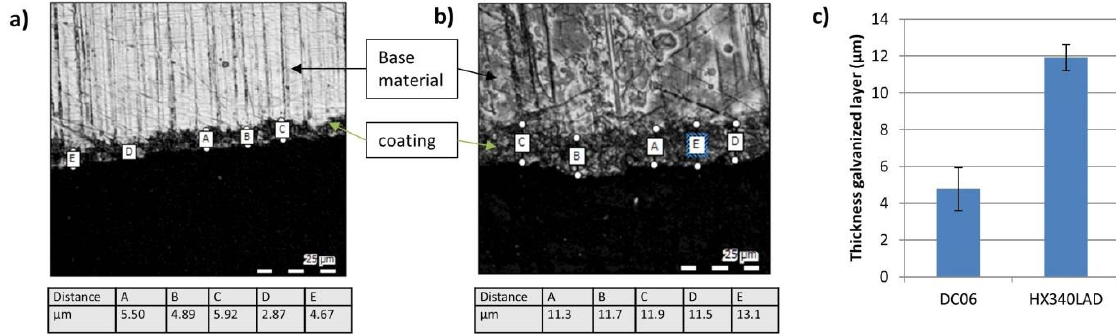
Figure 14. Visualization of the thickness measurement of galvanized layer of ( a ) DC06; ( b ) HX340LAD; ( c ) evaluation in diagram.